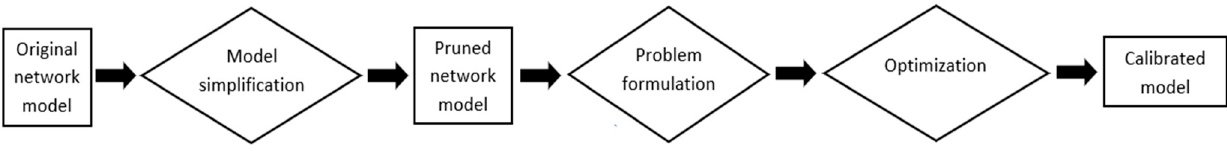
Figure 1. Calibration process in this study.